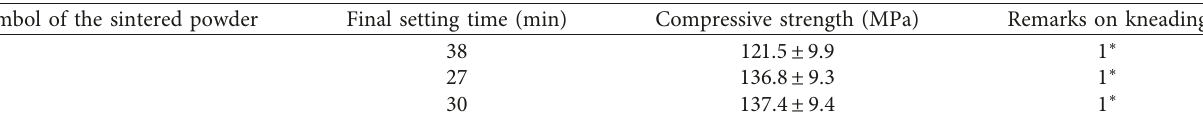
Table 5: Impact of the sintered powder granulation on the final setting time, compressive strength, and kneading capacity of the cements kneaded with the following proportions: 3.6 g of the sinter/1.0 ml of the 15% CaCl 2 solution. Symbol of the sintered powder